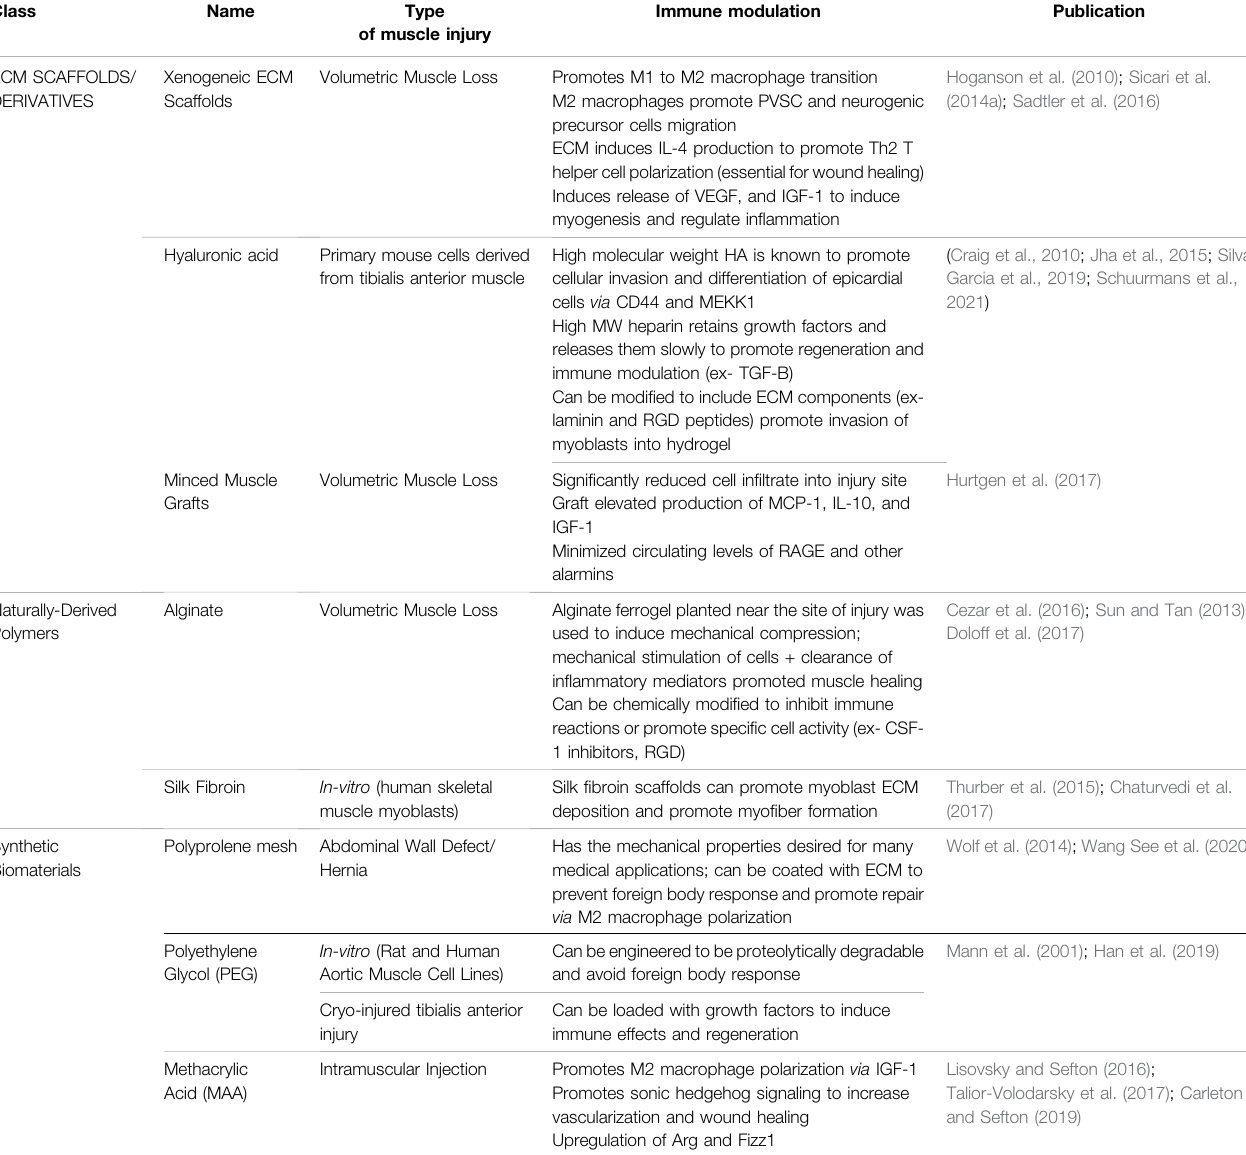
TABLE 1 | Biomaterials for skeletal muscle tissue regeneration and their immunomodulatory properties.